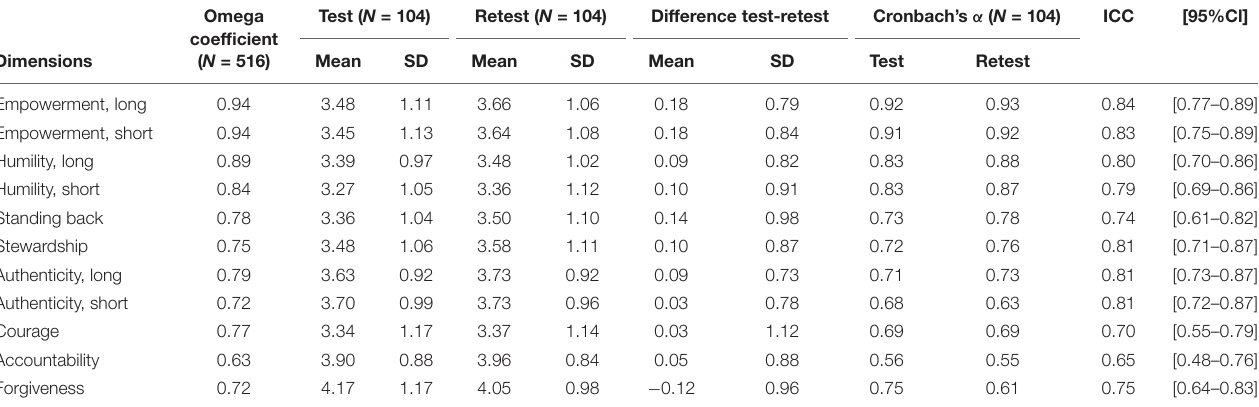
TABLE 5 | Omega coefficient and descriptive statistics and test-retest reliability of SLS-J and SLS-J-short dimensions. Omega Test ( N =